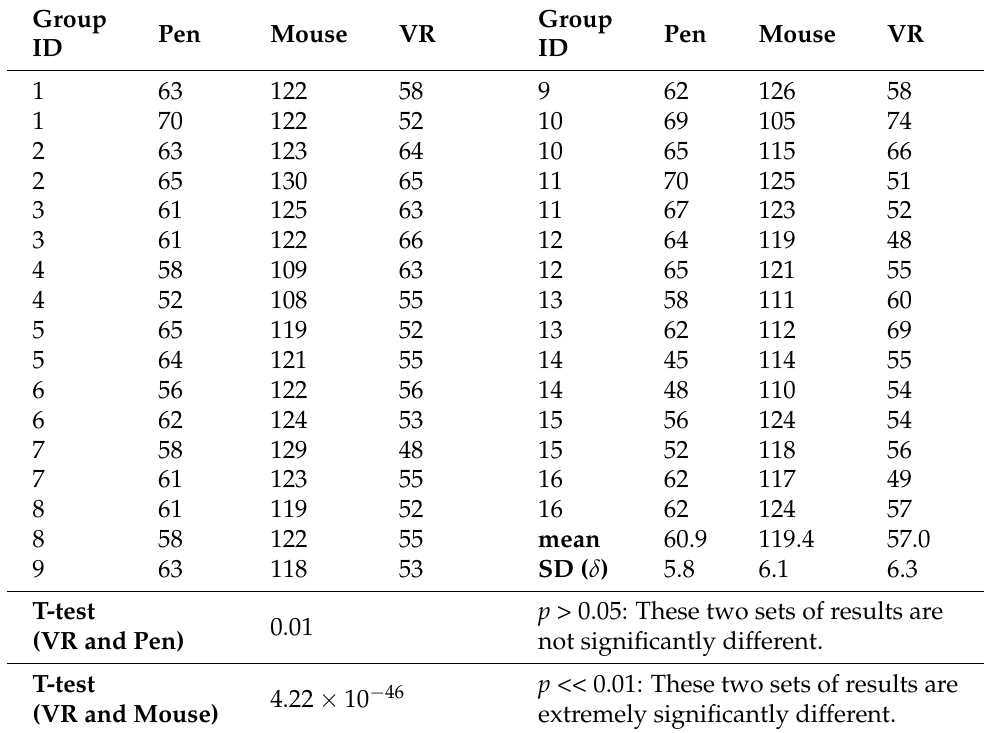
Table 4. Time cost results in seconds for the whiteboard efficiency evaluation experiment regarding the traditional whiteboard (pen), electronic whiteboard (mouse), and the proposed VR